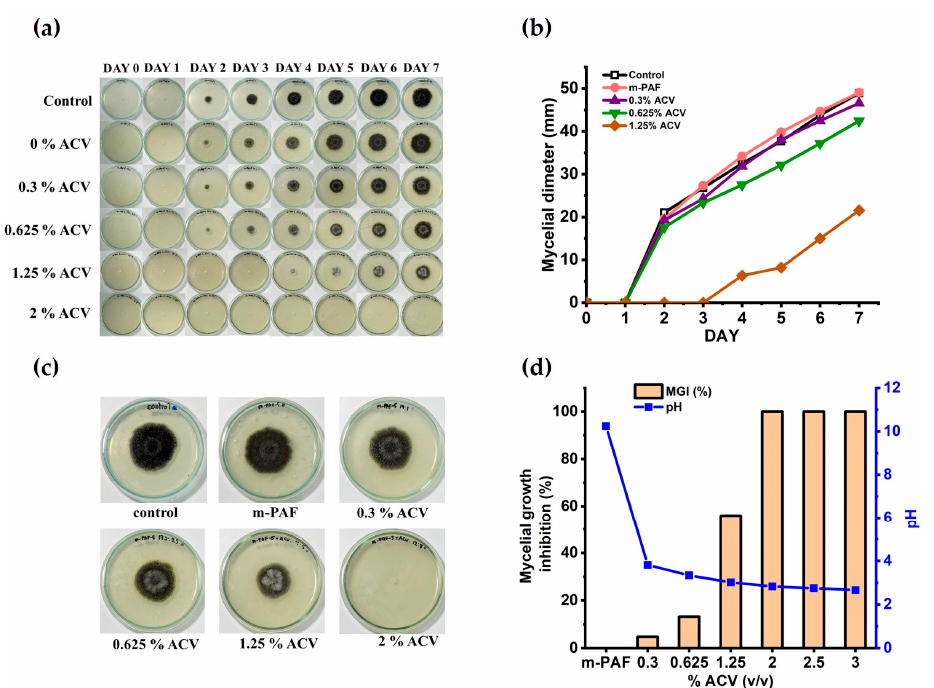
Figure 5. The mycelial growth of A. niger on the m-PAF and ACV/m-PAF adhesives in agar media was monitored for seven days. ( a ) Photos of the mycelial growth during the seven days of storage; ( b ) the diameter (mm) of fungal growth on days 0–7; ( c ) the mycelial growth after seven days of storage; ( d ) mycelial growth inhibition (%) at varying ACV concentrations. Table 3. The mycelial diameter (mm) of A. niger in the m-PAF and ACV/m-PAF adhesives at varying concentrations of ACV within seven days of storage. The results are reported as mean ± SD, while the group classifications (a, b, c, and d) within each column are listed based on the statistical analysis (significant differences; p ≤ 0.05) by using a Duncan’s multiple range test. The statistical analysis was conducted on each of the data